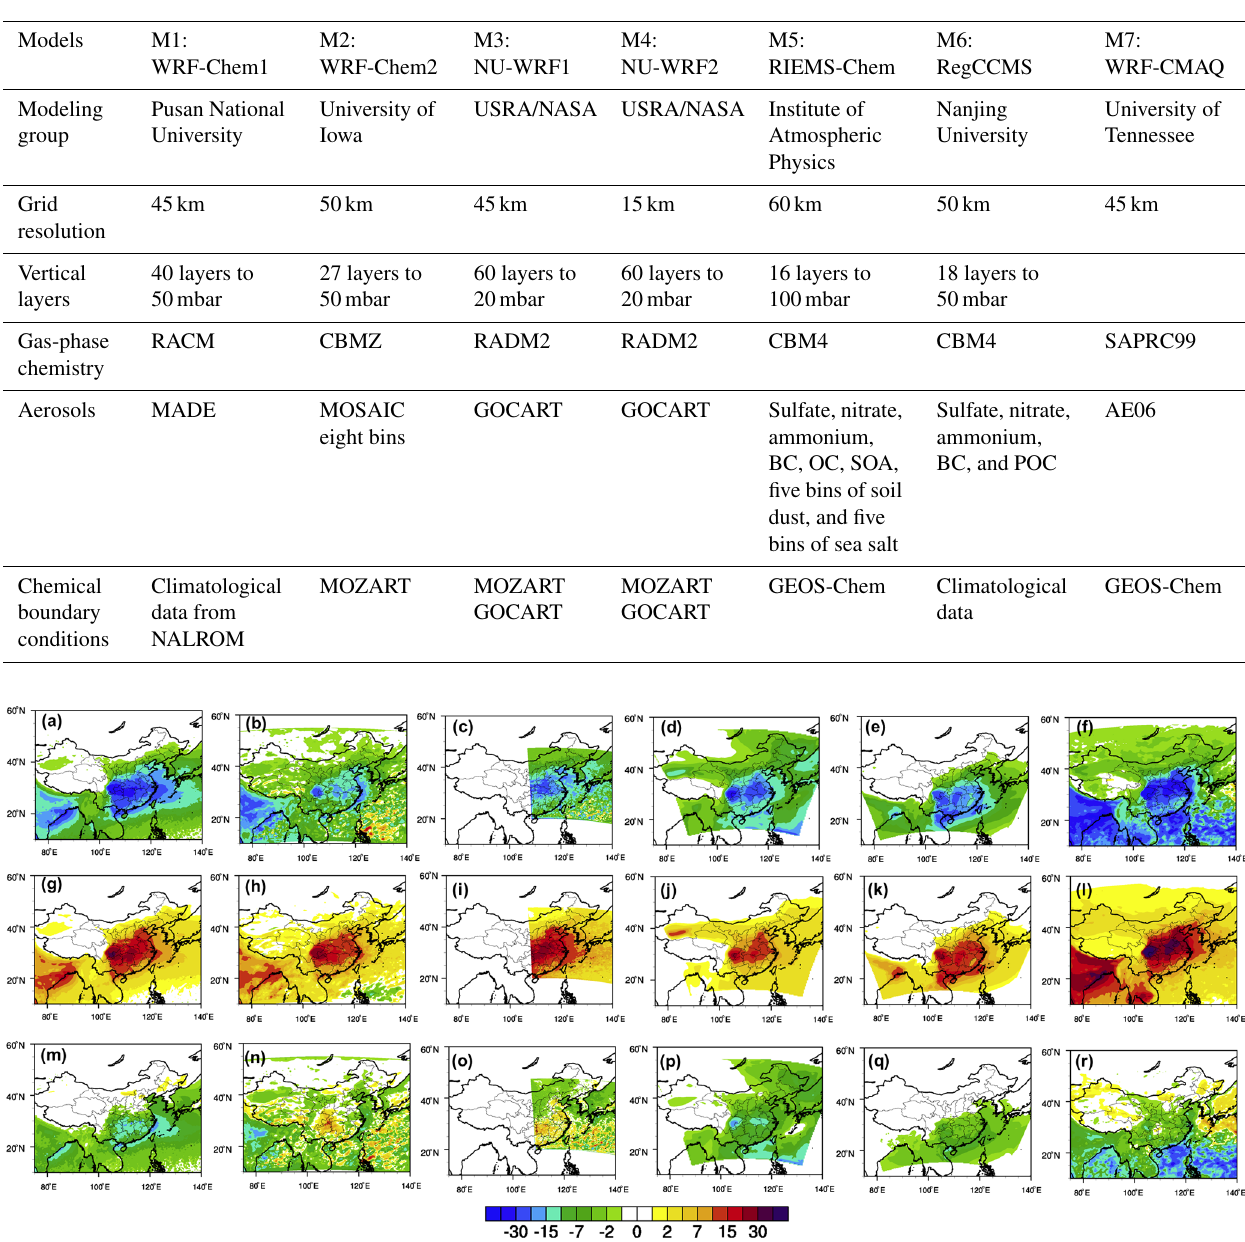
Figure 1. Monthly (January 2010) mean aerosol direct radiative forcing at the surface, inside the atmosphere, and at the top of the atmosphere inferred from M1 (a, g, m) , M2 (b, h, n) , M4 (c, i, o) , M5 (d, j, p) , M6 (e, k, q) , and M7 (f, l, r) (M1: WRF-Chem, Pusan National